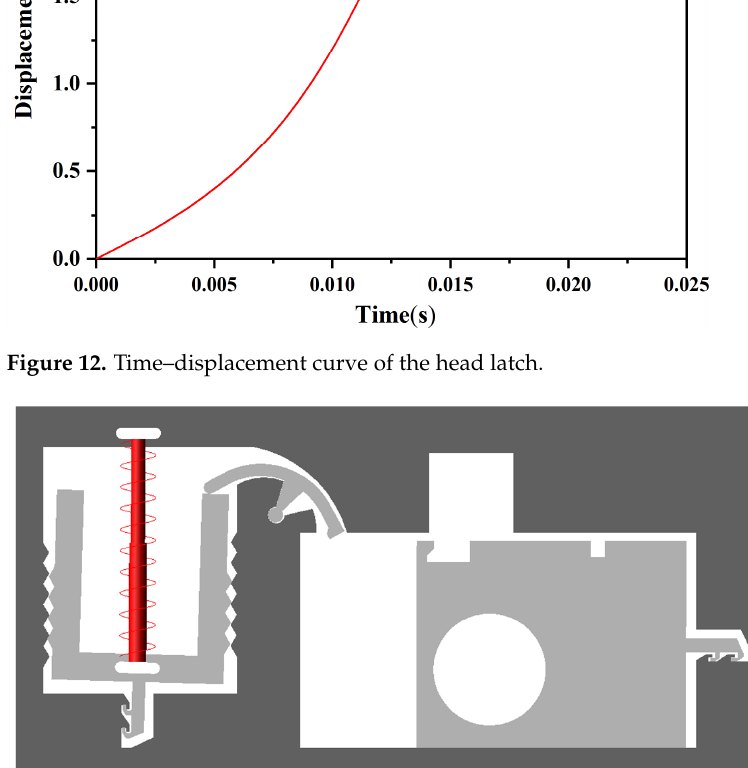
Figure 15. Characteristic dimensions. Table 2. Design values of characteristic dimensions. Project